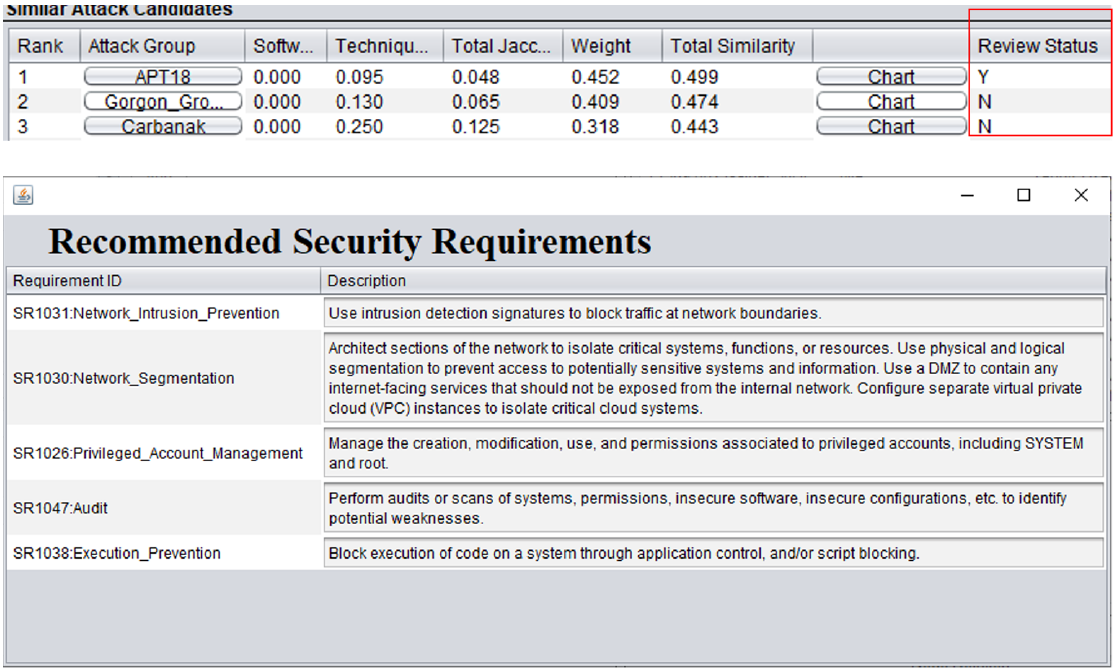
Figure 17. Reviewed and adopted security requirements.